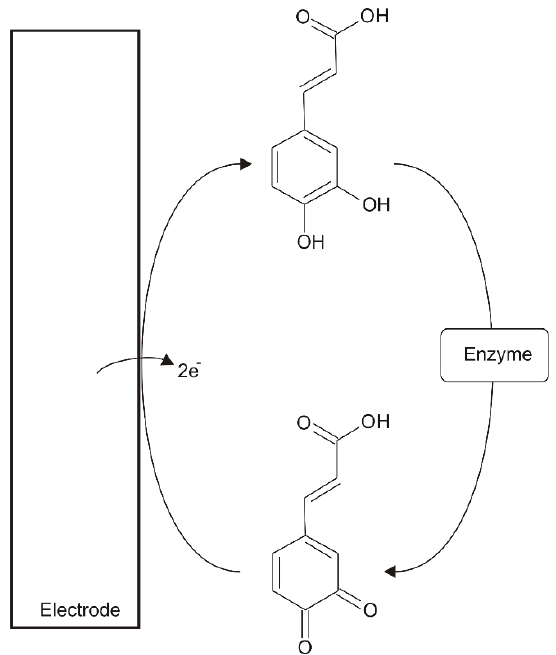
Scheme 2. Principle of caffeic acid detection of enzyme ‐ based biosensors.